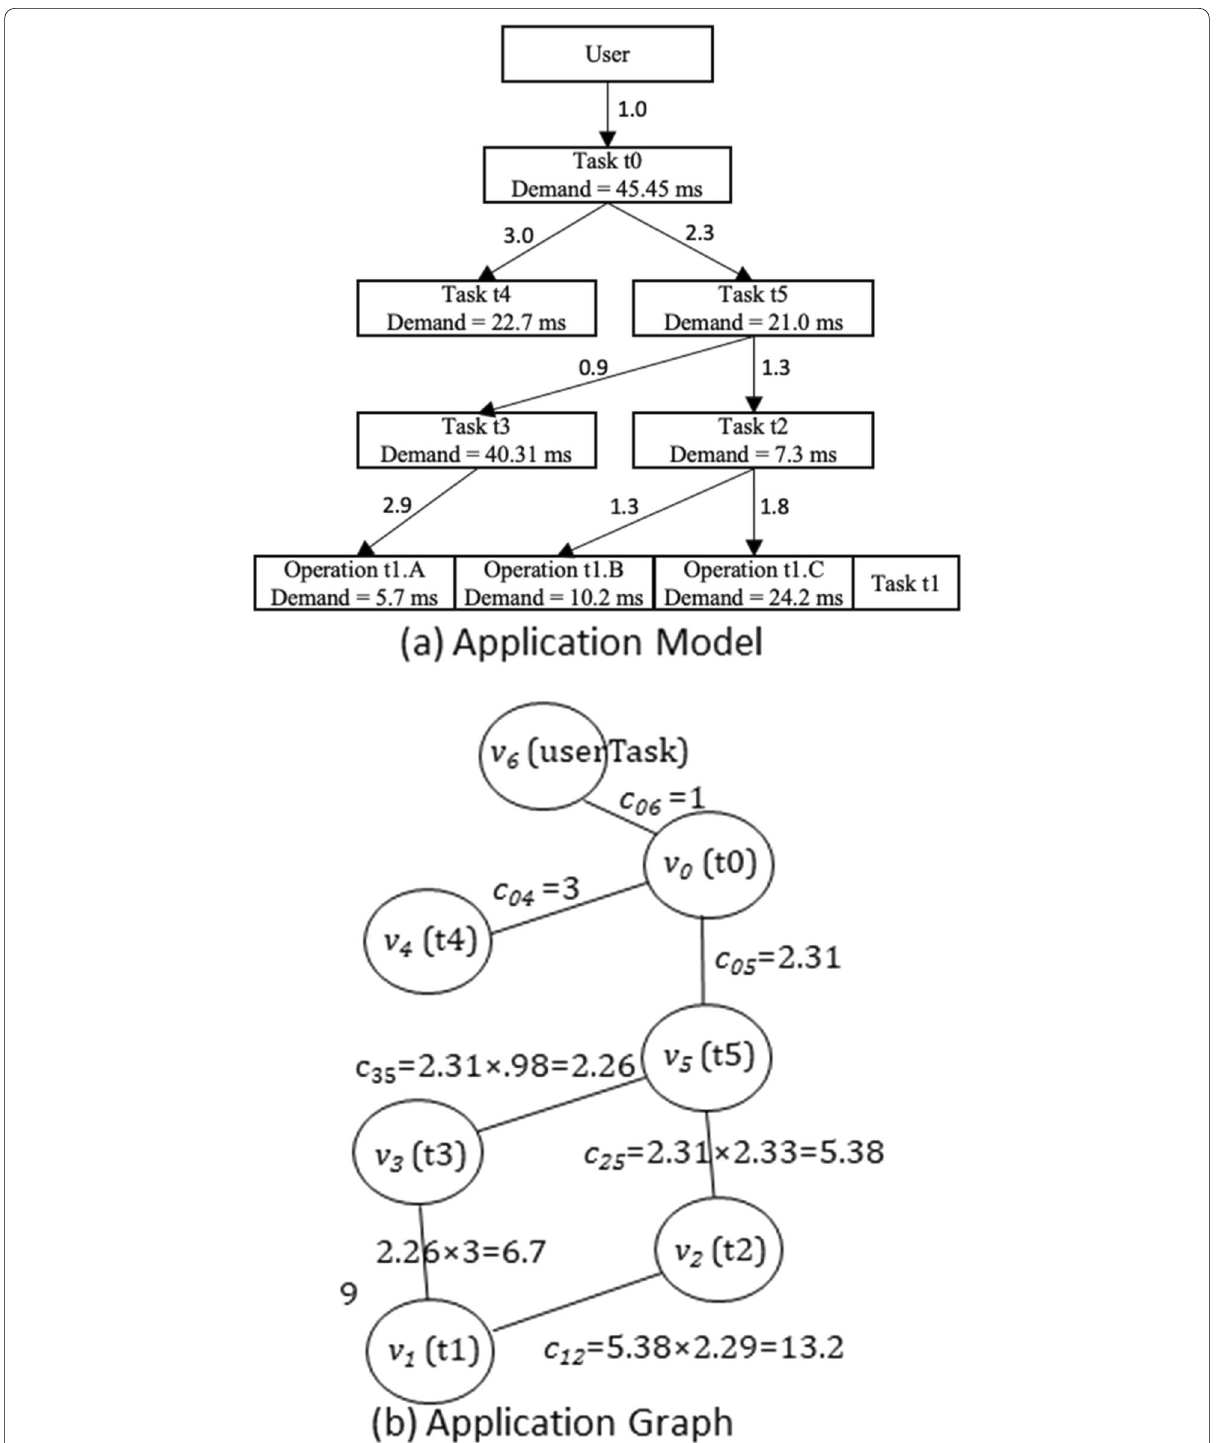
Fig. 3 An Application Model and its Graph. a Example Application Model in LQN Notation. b Corresponding Application Graph, Labelled with Mean Interaction